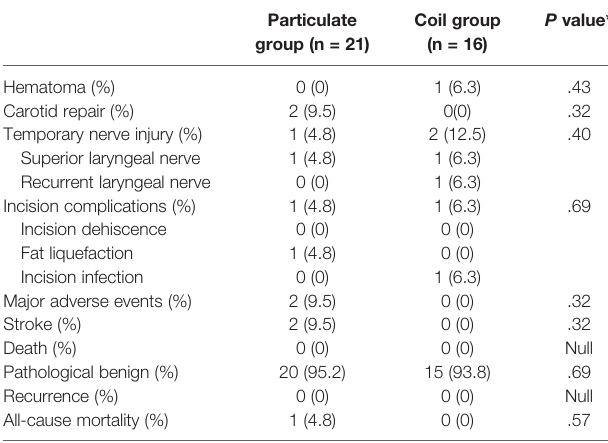
TABLE 1 | The baseline data of the study.